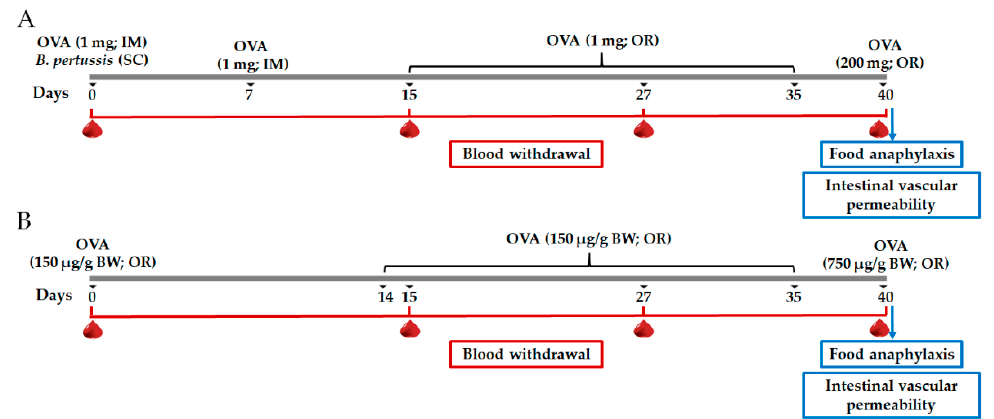
Figure 1. Schematic diagram of the food allergy (FA) experimental protocols. ( A ) FA protocol developed by intramuscular (IM) sensitization and oral (OR) challenge with ovalbumin (OVA); ( B ) FA protocol developed by OR sensitization and OR challenge with OVA. SC, subcutaneous; BW, body weight.